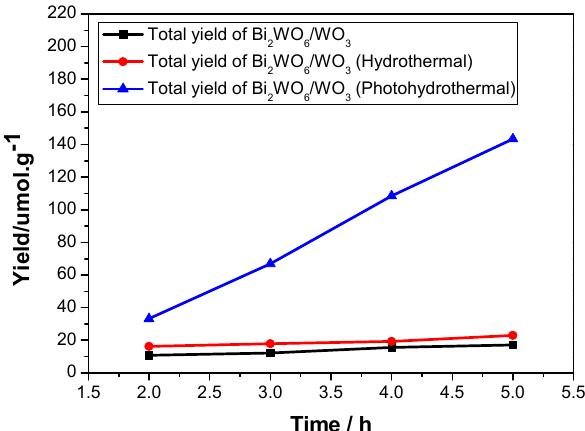
Figure 8. CO 2 photoreduction behavior of different Bi 2 WO 6 /WO 3 under a 300 W Xe lamp (CR = 8, 40 ◦ C): black line—Bi 2 WO 6 /WO 3 ; red line—Hydrothermal treated WO 6 /WO 3 (400 ◦ C, 5 h); blue line—Photohydrothermally treated Bi 2 WO 6 /WO 3 (natural light, CR = 600, 5 h).